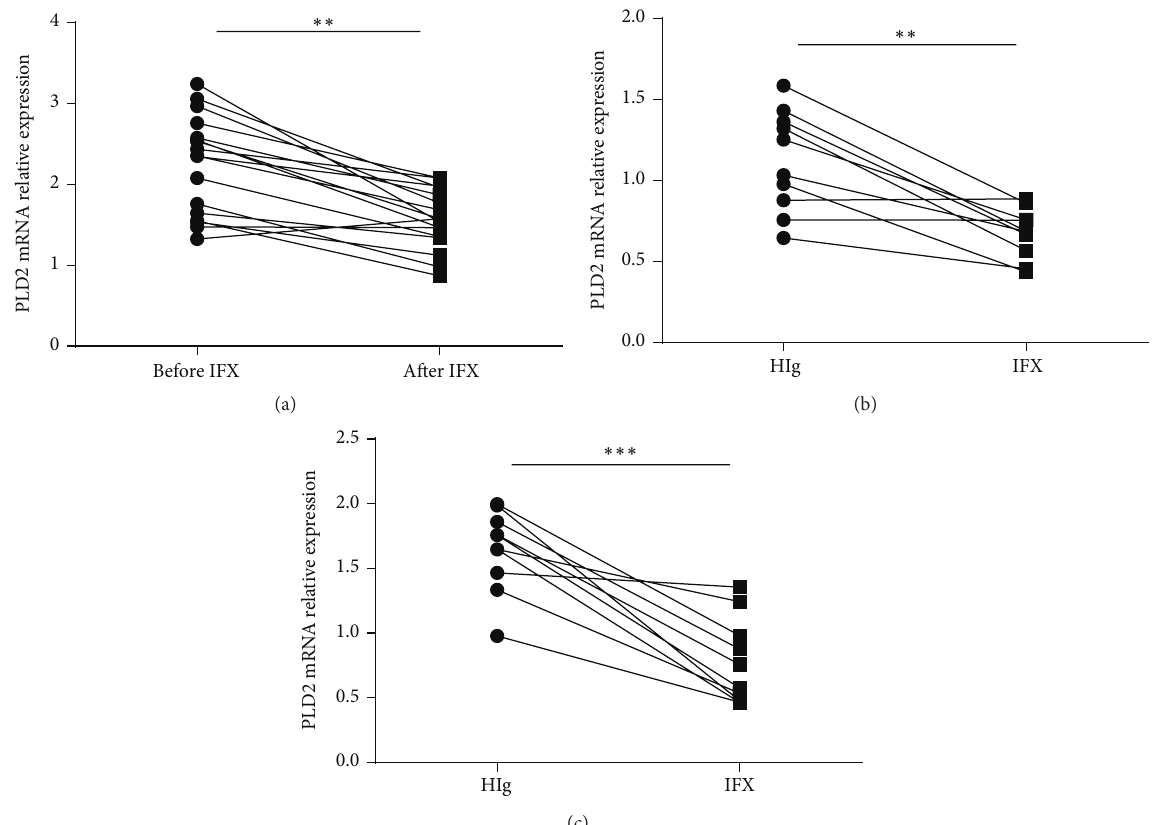
Figure 4: Anti-TNF therapy downregulates PLD2 expression. (a) Patients with A-CD ( 𝑛 = 17 ) were treated with anti-TNF mAb (IFX, 5 mg/kg) as indicated. Intestinal mucosal biopsies were collected before and at week 12 after the first infusion. Expression of PLD2 mRNA in intestinal mucosa was detected by qRT-PCR. ∗∗ 𝑝 < 0.01 versus that before IFX treatment. ((b) and (c)) Fresh colonic biopsies were harvested from inflamed mucosa in patients with active CD ((b) 𝑛 = 10 ) or active UC ((c) 𝑛 = 10 ) and cultured in vitro with IFX or control human IgG (HIg) (50 𝜇 g/mL) for 24 h. Expression of PLD2 mRNA was detected by qRT-PCR. ∗∗ 𝑝 < 0.01 and ∗∗∗ 𝑝 < 0.001 versus controls.